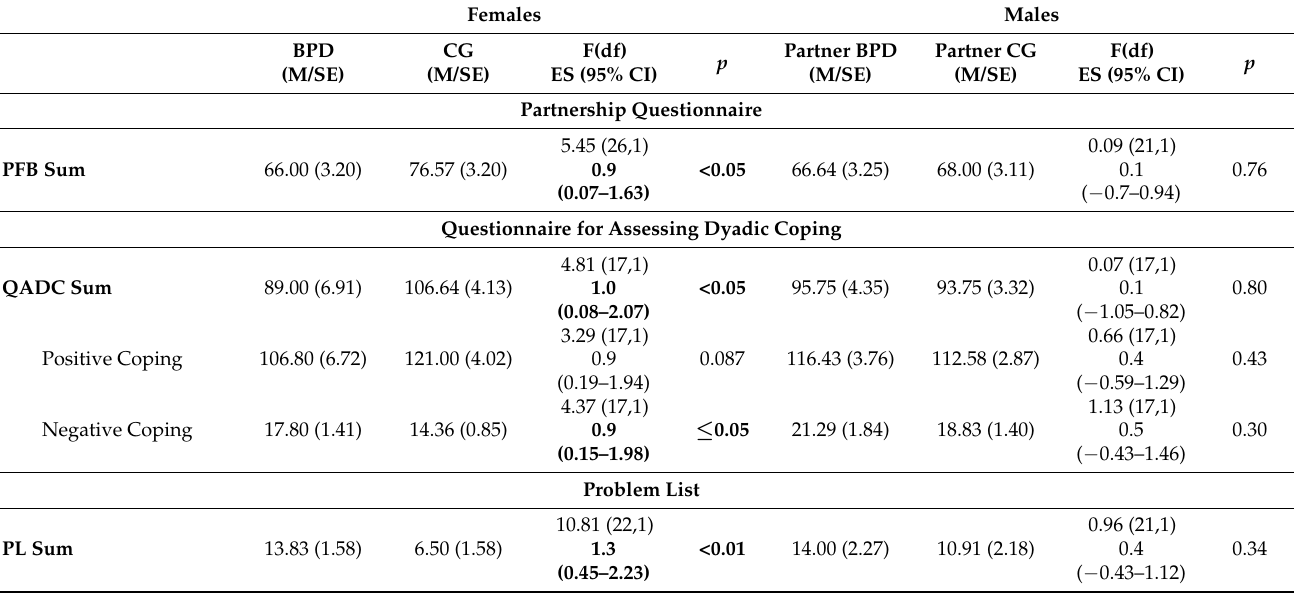
Table 4. Relationship Parameters between BPD and healthy controls by